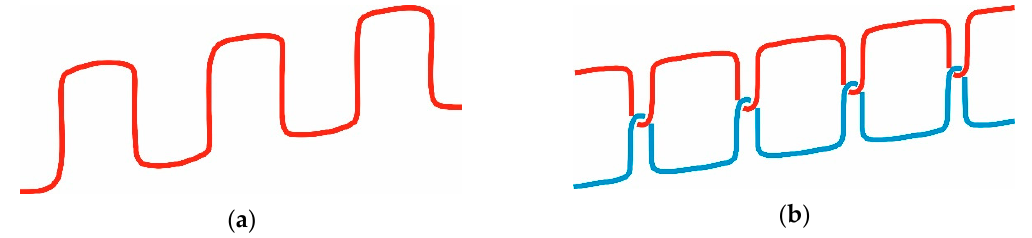
Figure 2. Embroidery seams. ( a ) Manual: Single lockstitch; ( b ) machine-made: Double lockstitch